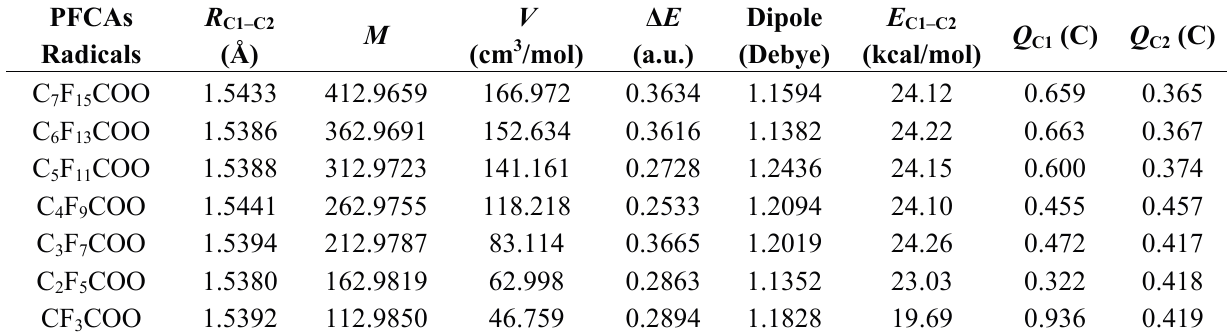
Table 4. The parameters used to make quantitative structure–activity relationship analysis.